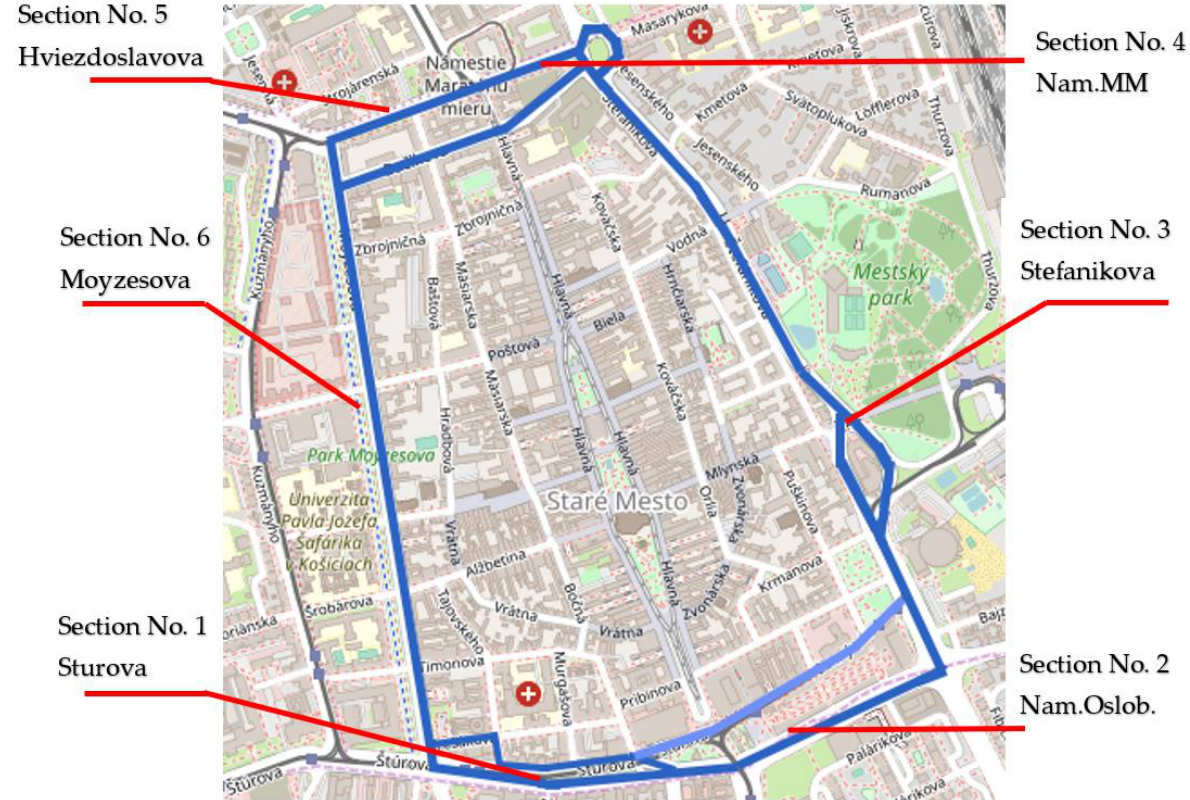
Figure 3. Illustration of the inner traffic circuit of the city of Košice (source elaborated by authors).